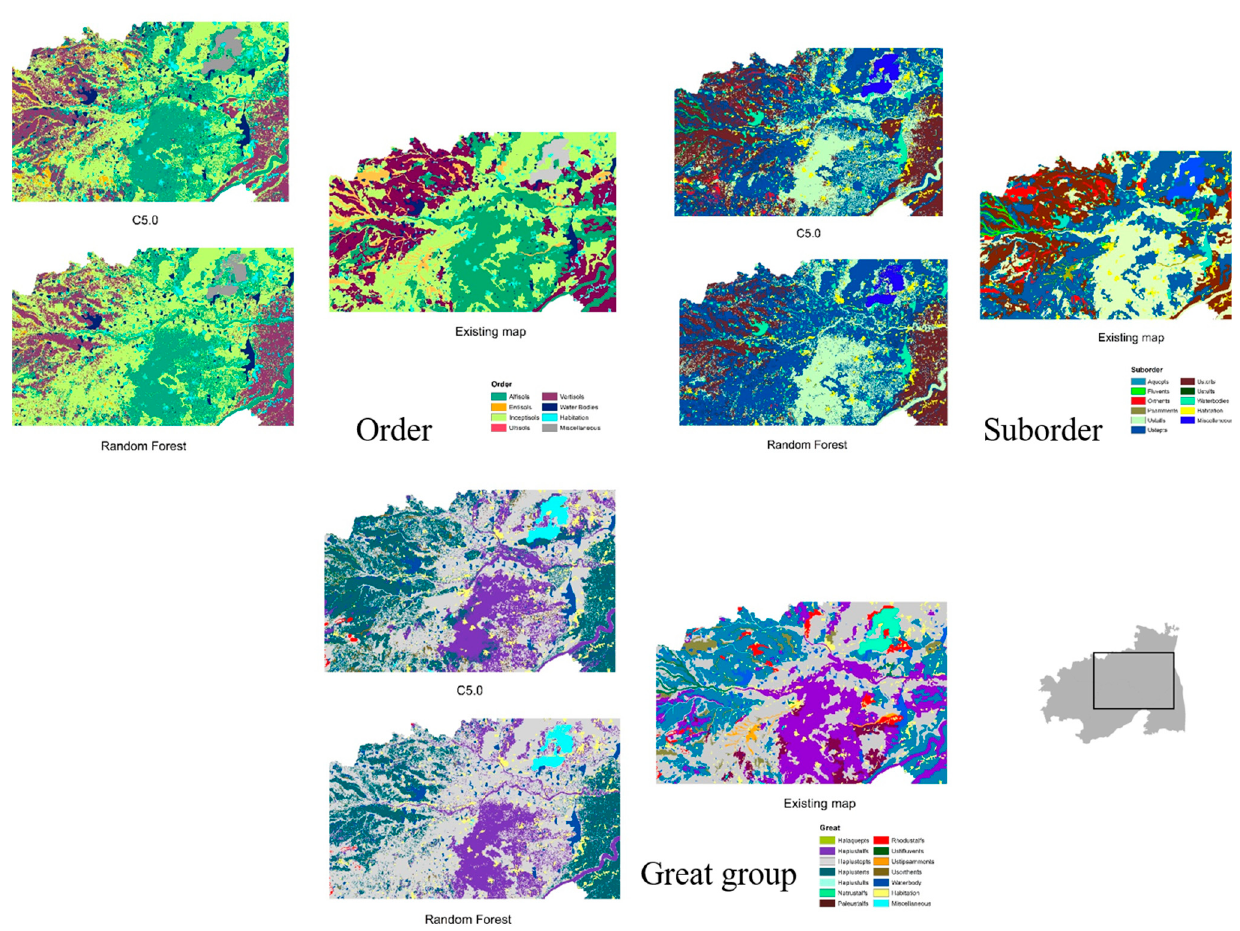
Figure 9. Visual assessment of the RF and Cubist algorithms’ predicted continuous variables maps.